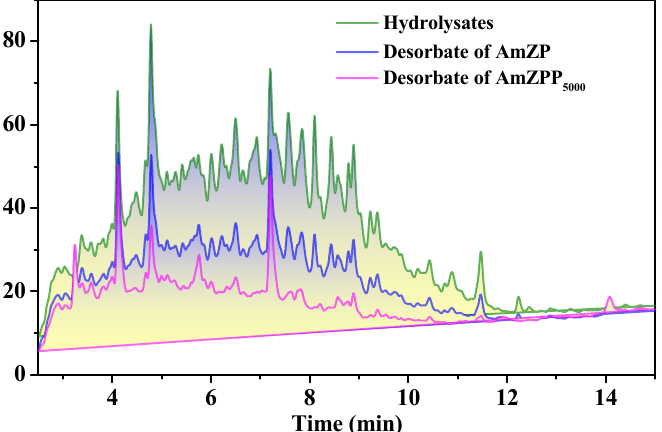
Figure 11. HPLC chromatogram on a Zorbax SB C18 column of samples. Experiments were carried out with a linear gradient of 5–50% acetonitrile in water (containing 0.1% TFA) over 15 min at a flow rate of 1 mL/min.